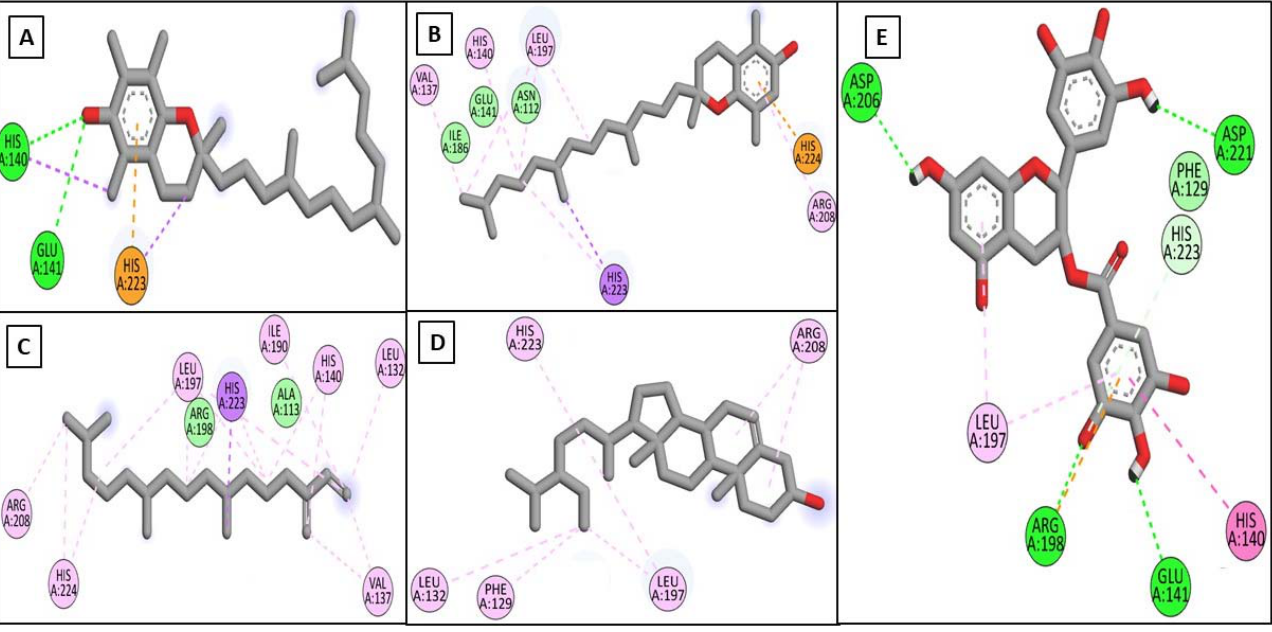
Figure 5. 2D binding modes of α -tocopherol ( A ), β -tocopherol ( B ), neophytadiene ( C ), γ -sitosterol ( D ), and EGCG ( E ) to the active binding sites of elastase.